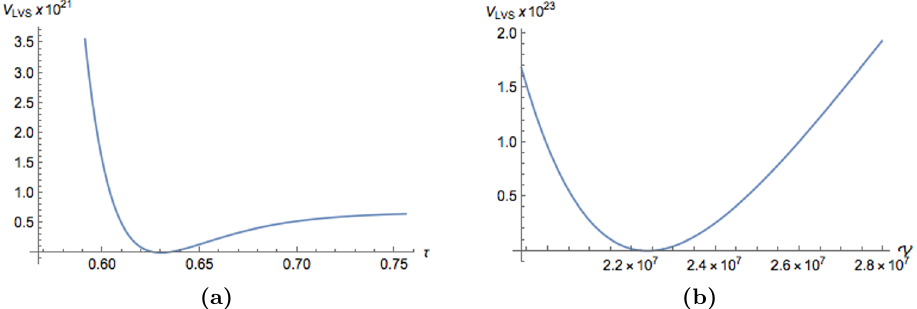
Figure 3. Potential against τ (a) and V (b) where the other direction were fixed using (3.21) and (3.22), respectively. The plots are made using the parameters given in table